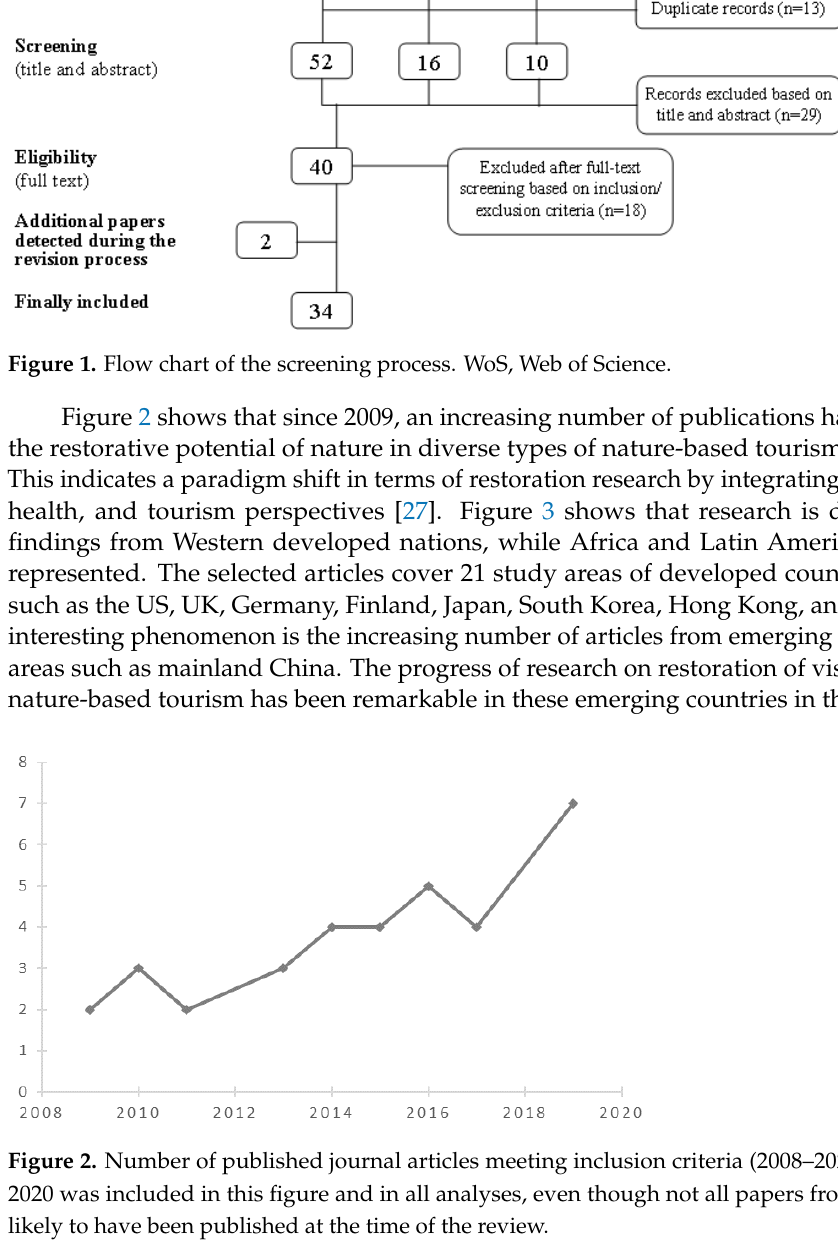
Figure 3. Regional distribution of case studies of this review. Note: Regions are defined by the number of cases identified in them. 3.2. Groups of Publications According to Main Content According to the narrative analysis, all the articles that met the review criteria were characteristically suitable in terms of design, methods, theoretical background, and outcomes. Based on the focus of the respective articles, they were grouped into the following four “content groups”: a)